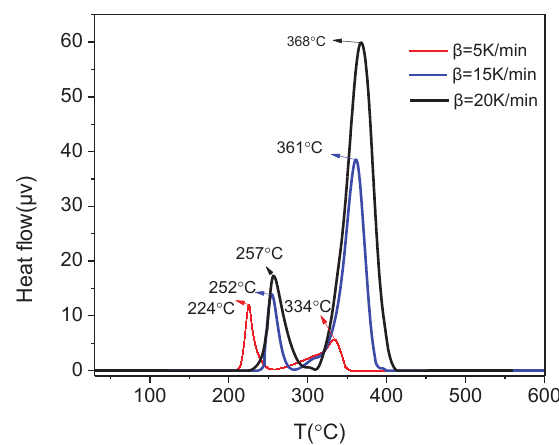
Figure 3: Differential thermal analysis (DTA) curve of NPL-10.